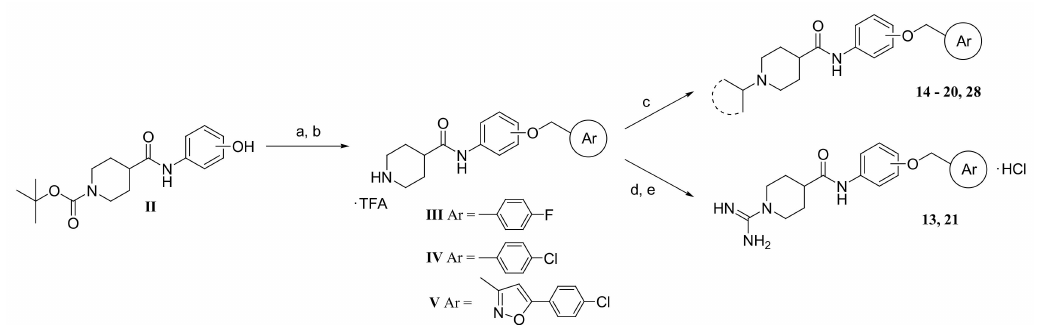
Scheme 2. (a) NaH, Ar-CH 2 -X, dry DMF, r.t., 4 h; (b) CH 2 Cl 2 , CF 3 COOH, r.t., 2 h; (c) acetone or cyclopentanone, Na(CN)BH 3 , MeOH, overnight; (d) 1,3-bis(tertbutoxycarbonyl)-2-methyl-2-thiopseudourea, HgCl 2 , dry DMF, 0 ◦ C to r.t., 24 h; (e) 4M HCl in dioxane, CHCl 3 , 0 ◦ C, 2